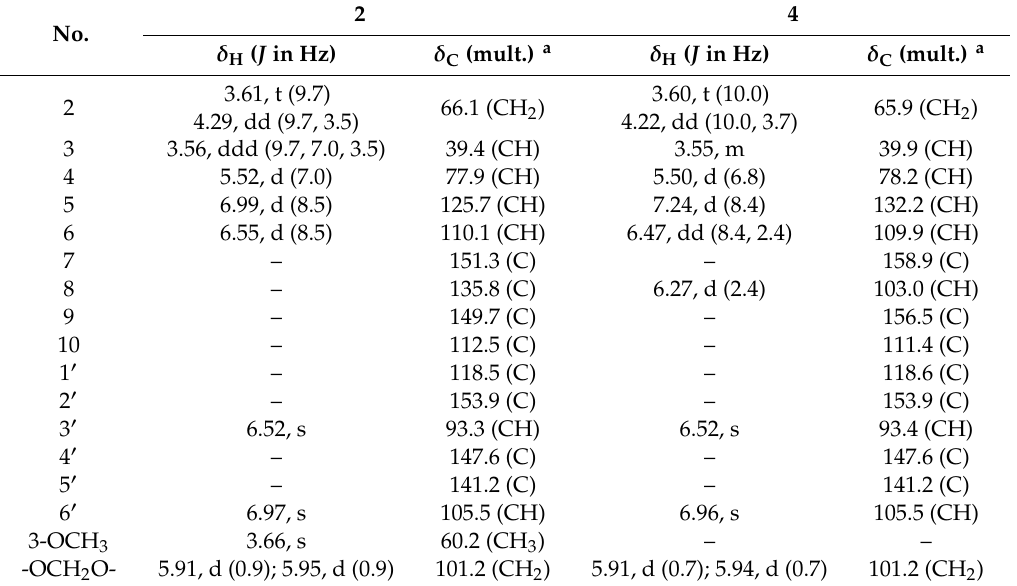
Table 1. 1 H (400 MHz) and 13 C (100 MHz) NMR data for compounds 2 and 4 in dimethyl sulfoxide (DMSO)- d 6